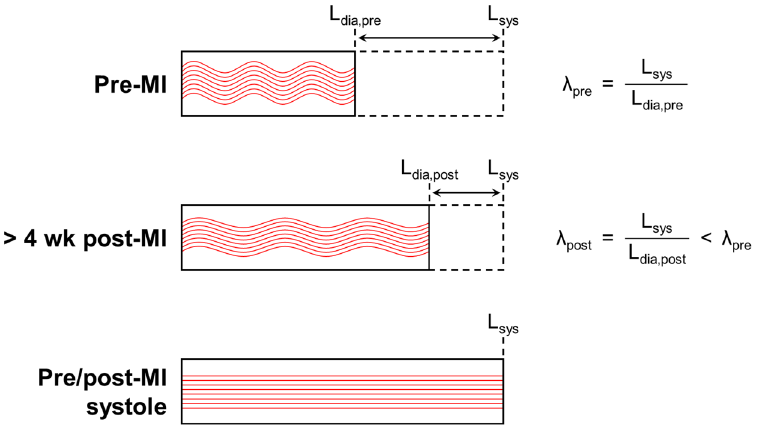
Figure 9. Uniaxial schematic of MV leaflet configurations that were considered in the present study, with red curves depicting how the collagen fibre geometry within the tissue would evolve with stretch (not to scale). Reference lengths for pre-MI diastole ( L dia,pre ), post-MI diastole ( L dia,post ), and systole ( L sys ) are labelled, as well as systolic stretches with respect to pre-MI and post-MI diastolic configurations ( (cid:31) pre and (cid:31) post , respectively). Note that L dia,post > L dia,pre and a constant L sys imply that (cid:31) post < (cid:31) pre , even in the absence of active